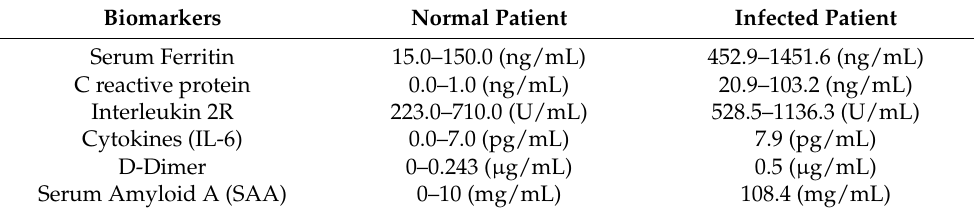
Table 1. COVID-19 inflammatory biomarkers: normal vs. infected